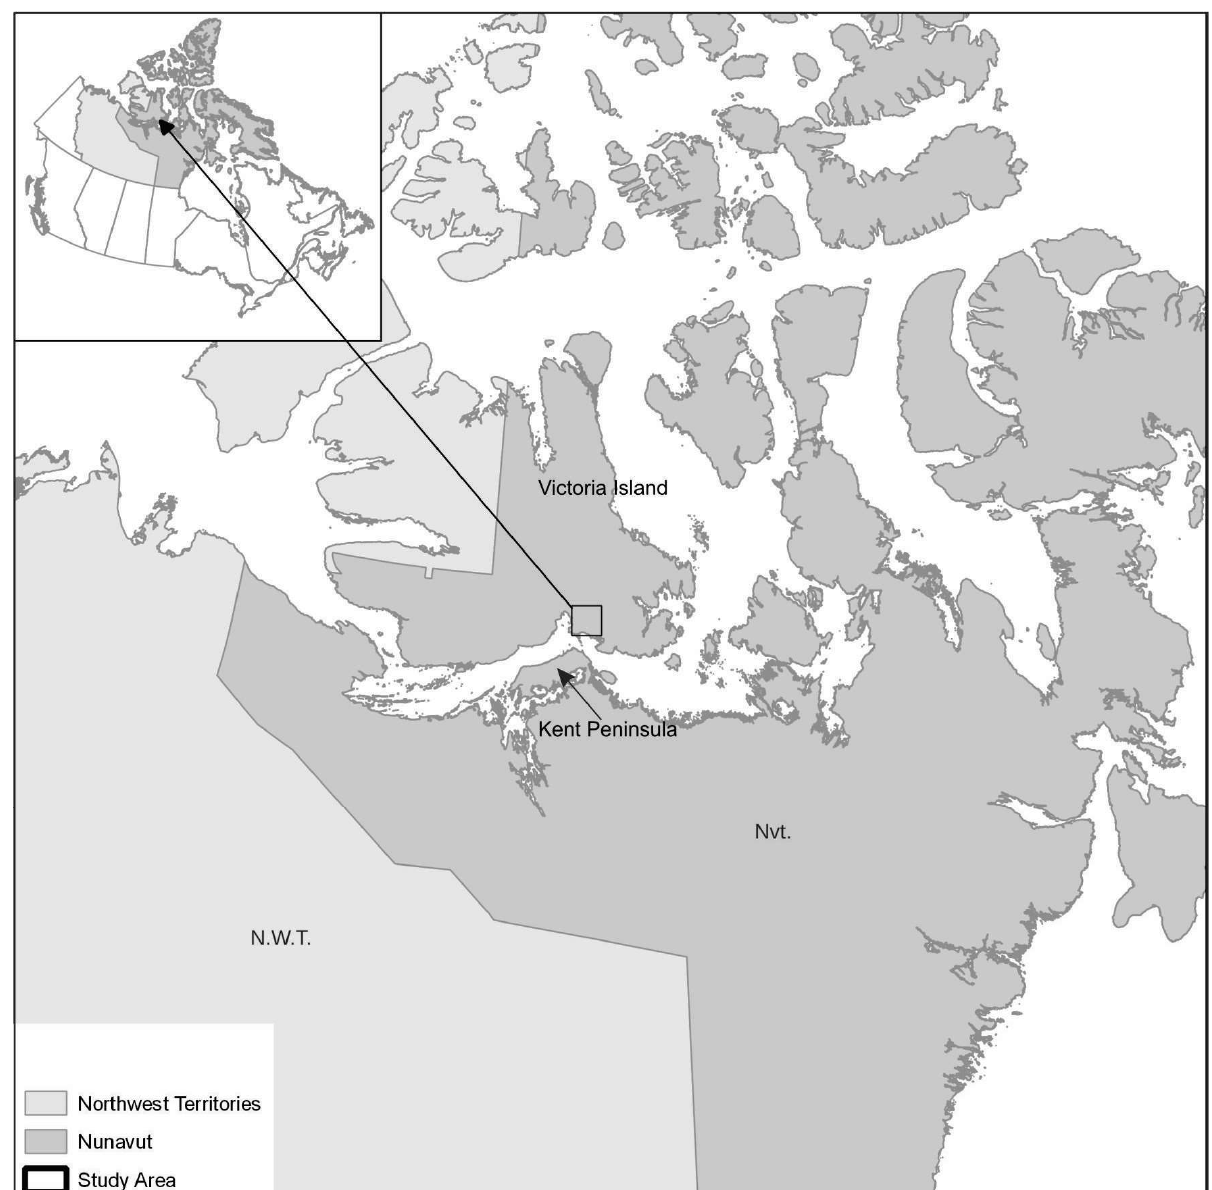
Figure 1. Victoria Island (Kitlineq), Canada.